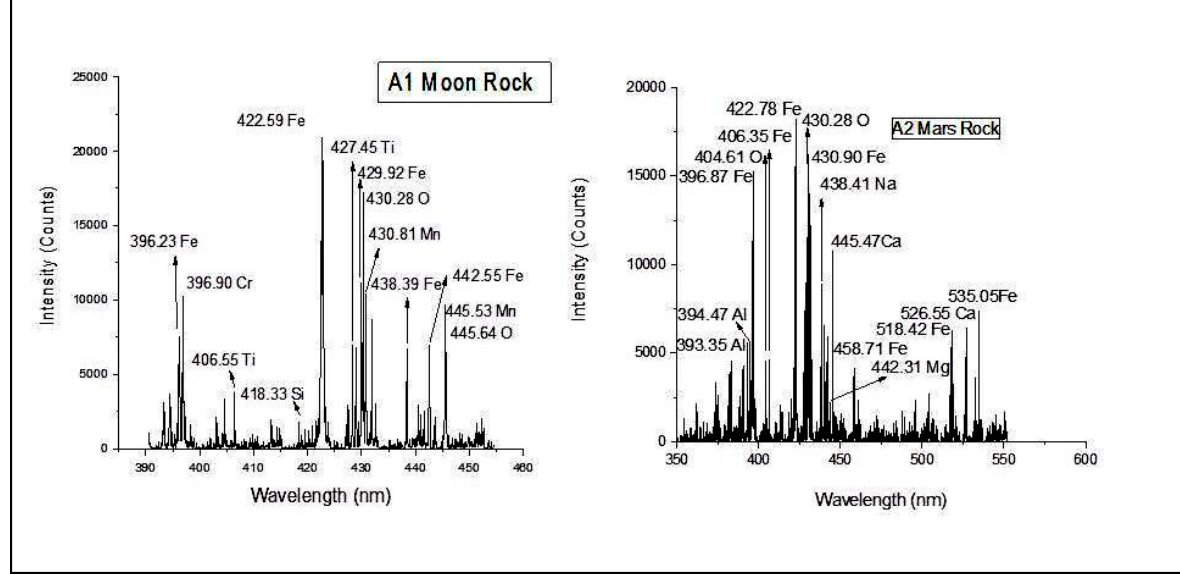
Figure 3. LIBS spectra of Samples A1 and A2 recorded using an echelle spectrograph [28].